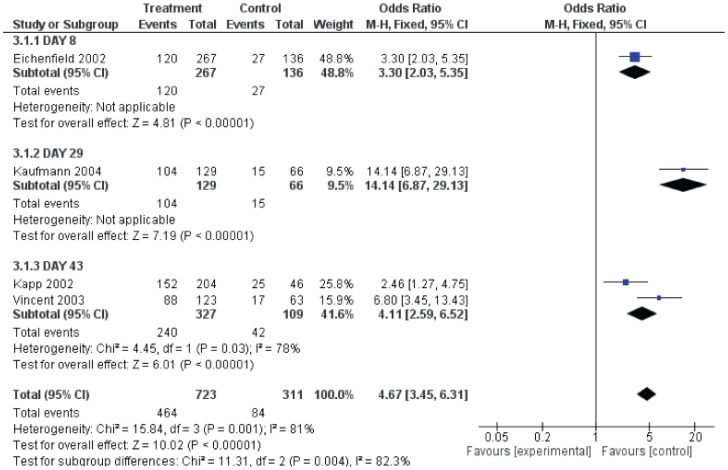
Analysis of care giver's assessment (pimecrolimus vs pruritus).